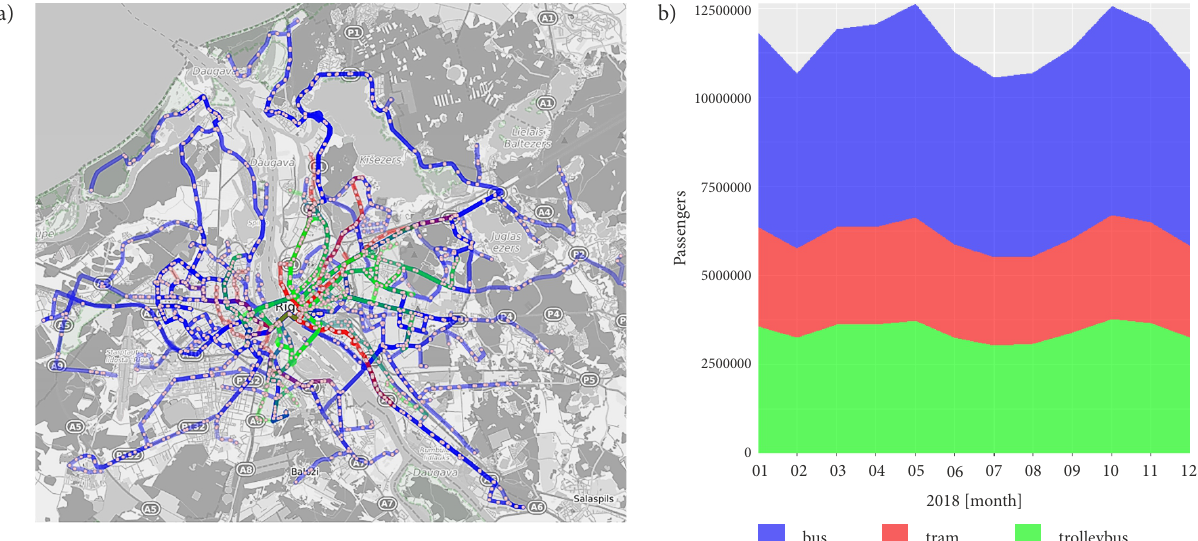
Figure 5. PT system of Riga (bus routes are coded as blue, tram routes as red, and trolleybus routes as green): a – topology of the PT of Riga; b – monthly dynamics of number of served passengers in 2018